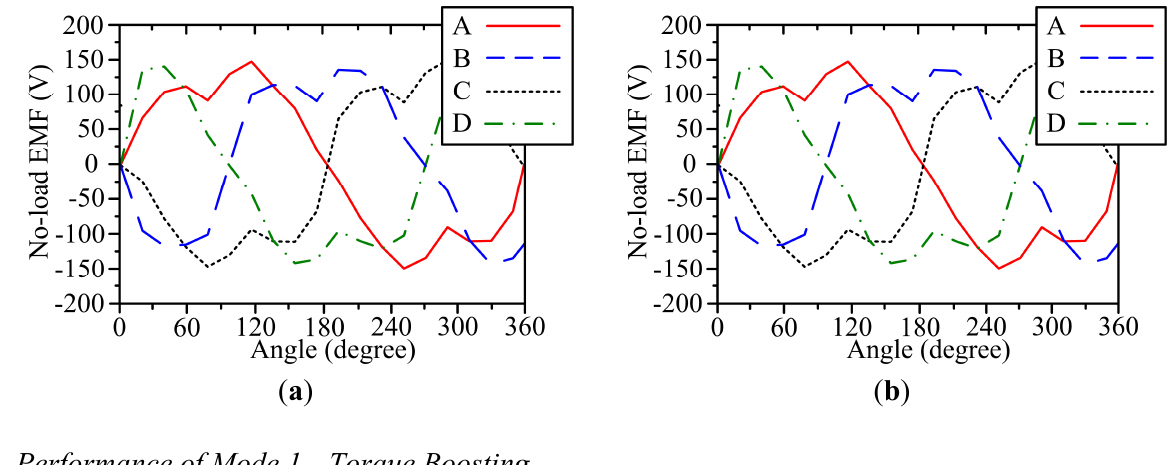
Figure 10. No-load electromotive force (EMF) waveforms at rated conditions: ( a ) Winding 1; and ( b ) Winding